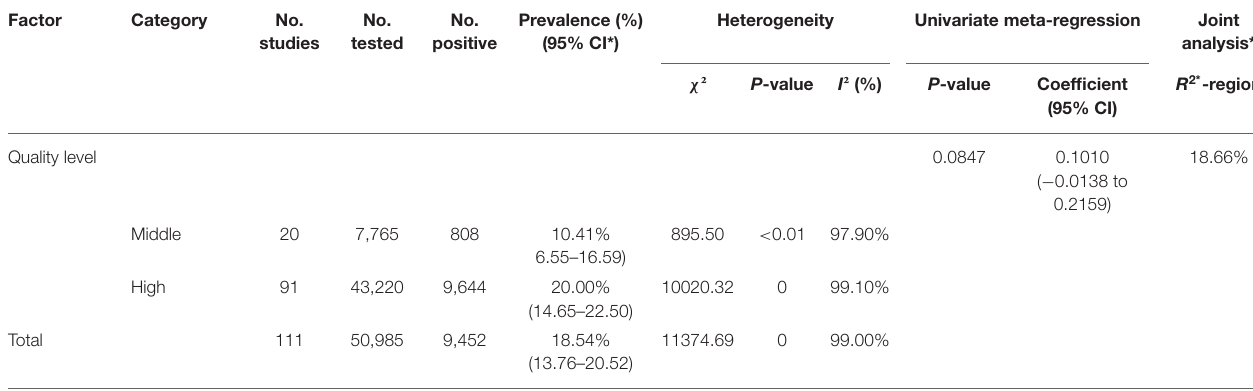
In high-prevalence areas of Bd (more at risk compared